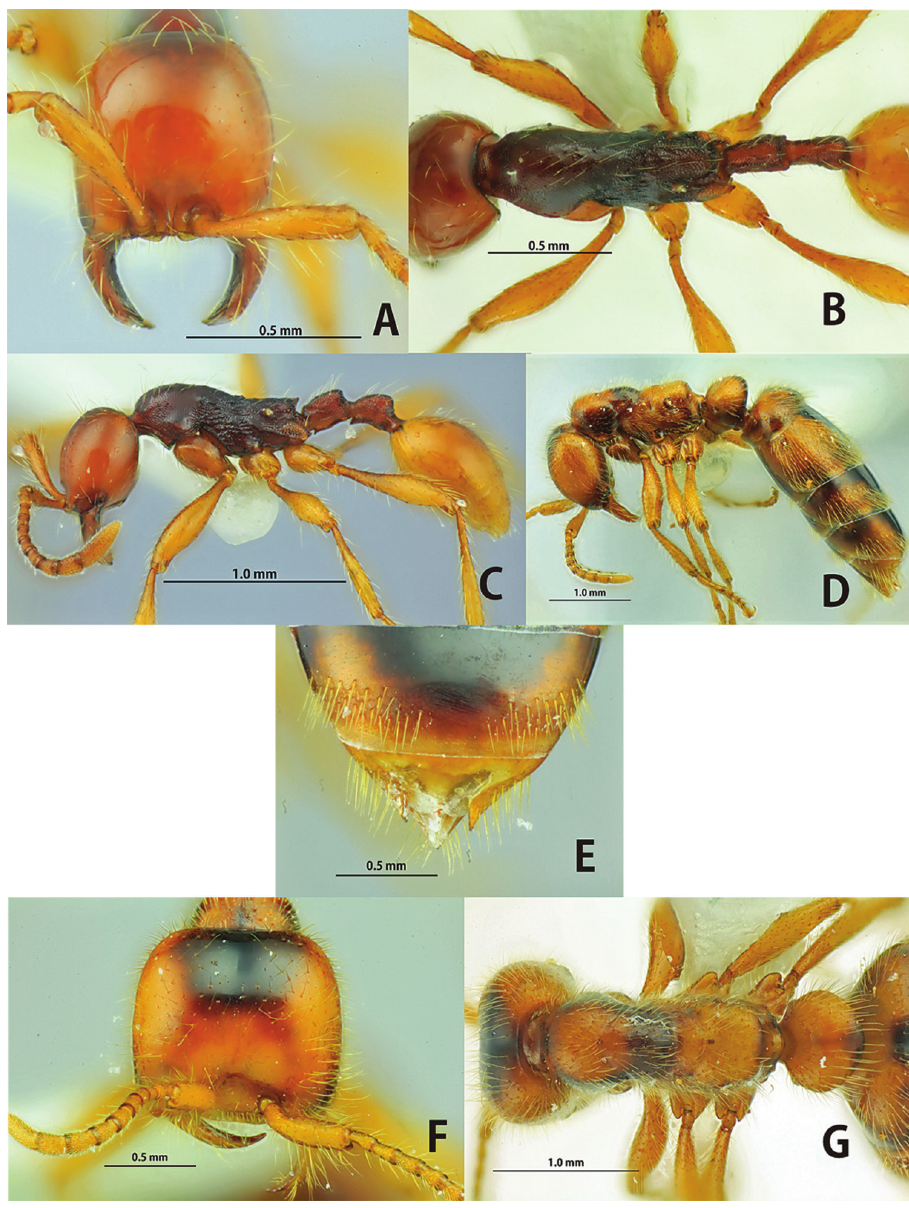
Figure 5. Aenictus cylindripetiolus ( A, B, C holotype D, e, F, G paratype queen). A, F Head in full-face view B, G body in dorsal view C, D body in profile e tip of gaster (6 th gastral tergite and width of gap between anterior clypeal margin and mandibles about 1.4 times as broad as maximum width of mandible. Promesonotum convex dorsally and sloping gradu- ally to metanotal groove; mesopleuron relatively short, demarcated from metapleuron